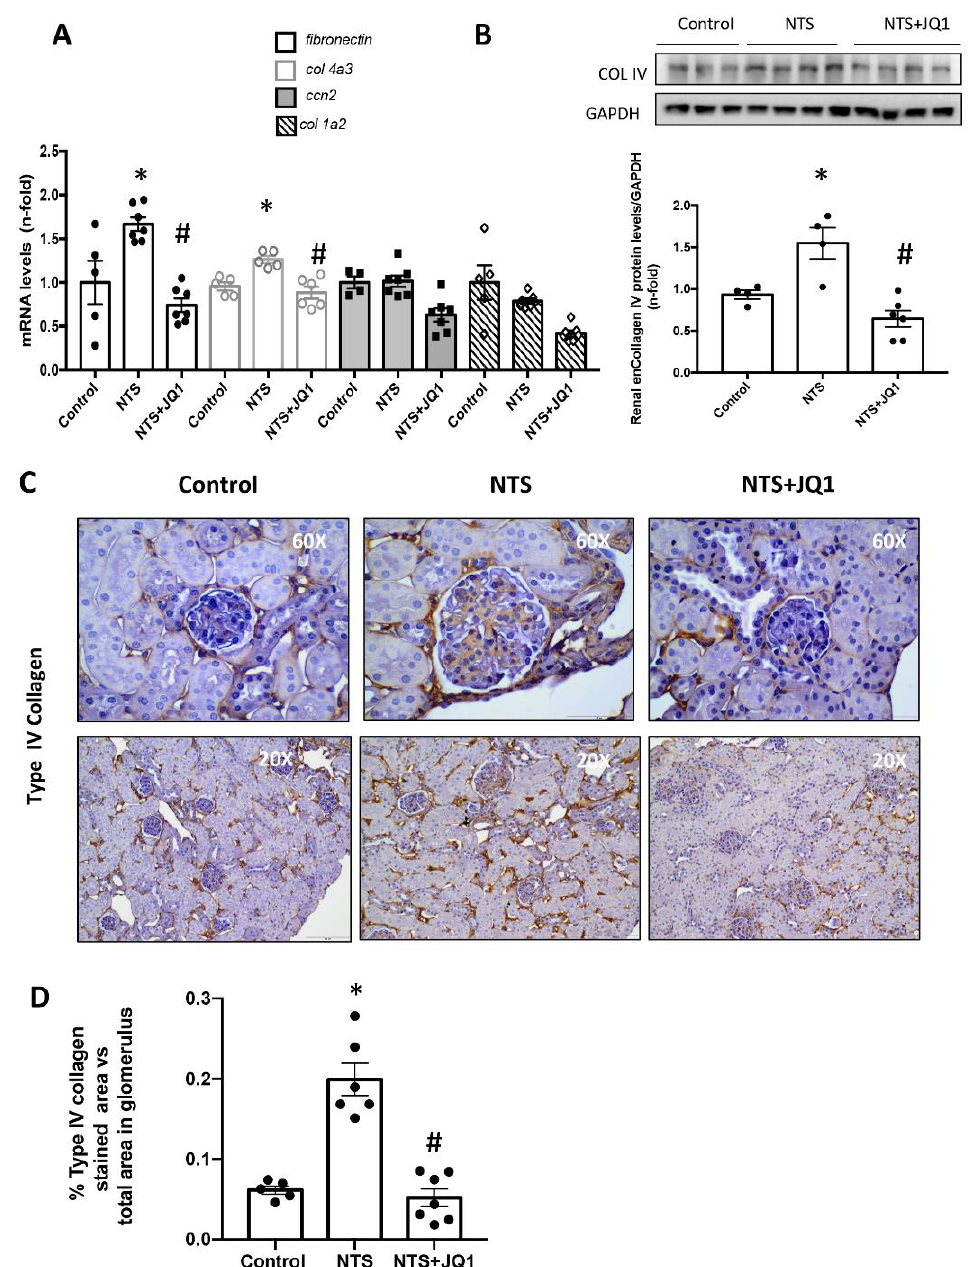
Figure 2. JQ1 reduced renal type IV collagen overexpression at the gene and protein levels in nephrotoxic nephritis. Mice were treated daily with JQ1 (100 mg/kg/day) or vehicle, starting before the first NTS injection. ( A ) RNA was isolated from frozen whole kidney samples, and α 3 chain type IV collagen ( Col4a3 ); type I collagen ( ColI ); fibronectin , and Ccn2 gene expression levels were evaluated by real-time qPCR. ( B ) Protein levels of COLIV were quantified by Western blot in total kidney extracts. The figure shows representative blots where GAPDH was used as a loading control. Data are expressed as the mean ± SEM of 5–7 animals per group. * p < 0.05 vs. control; # p < 0.05 vs. NTS-injected mice. ( C ) Immunohistochemistry with an anti-type IV collagen antibody in paraffin-embedded kidney sections. A representative animal from each group was shown (200 × magnification). A detailed image of glomeruli was included (600 × magnification). ( D ) Type IV collagen staining quantification. Scale bar represents 100 μm (200×) and 50 μm (600×).